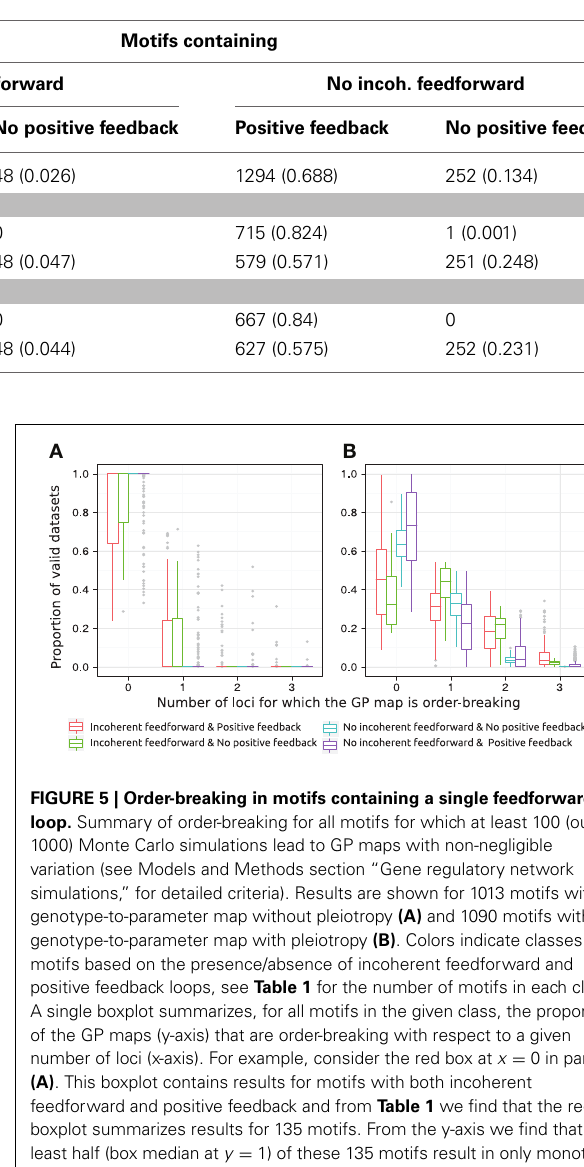
Table 1 | Frequencies (proportion of row total in parenthesis) of incoherent feedforward and positive feedback loops in subsets of the 1881 studied motifs.